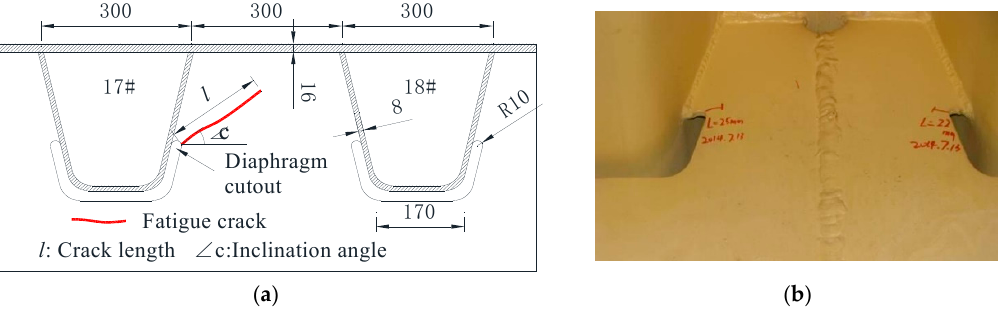
Figure 3. Structural details and fatigue cracks in the rehabilitation region: ( a ) The drawing; ( b ) the photo.